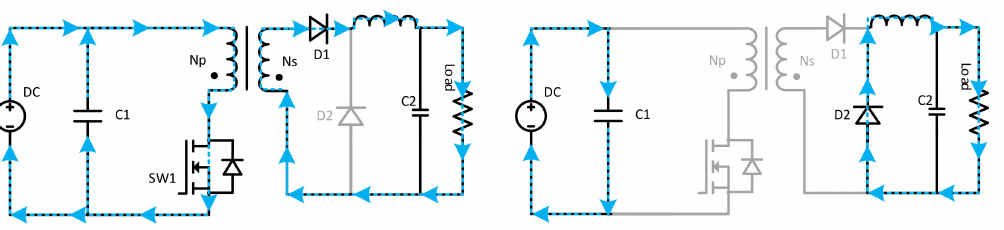
Figure 3. Conventional forward converter current loop during primary ( left ) ON time and ( right ) OFF